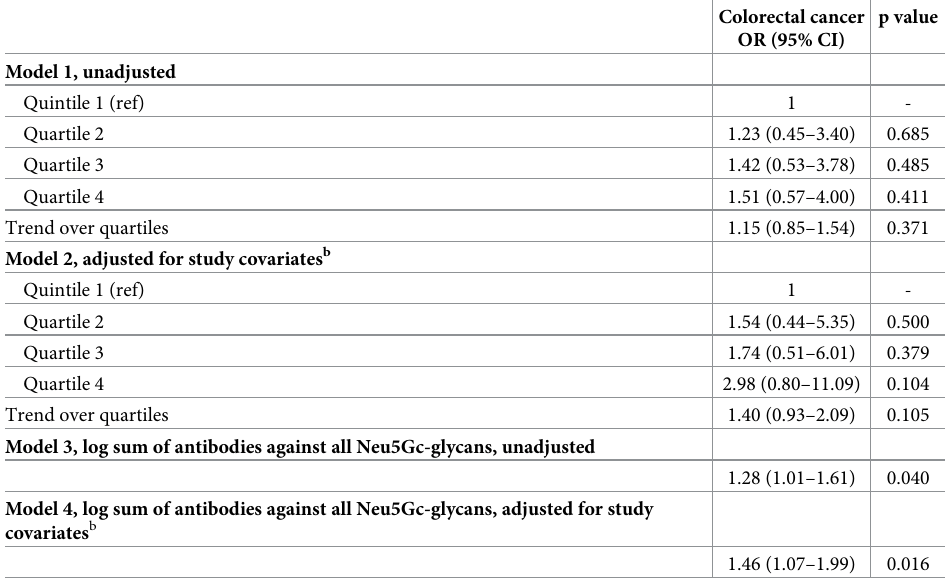
Table 6. Matched logistic regression a models for the sum of antibodies against all Neu5Gc-glycans measured in quartiles, and log transformed sum of antibodies against all Neu5Gc-glycans in the EPIC-Norfolk